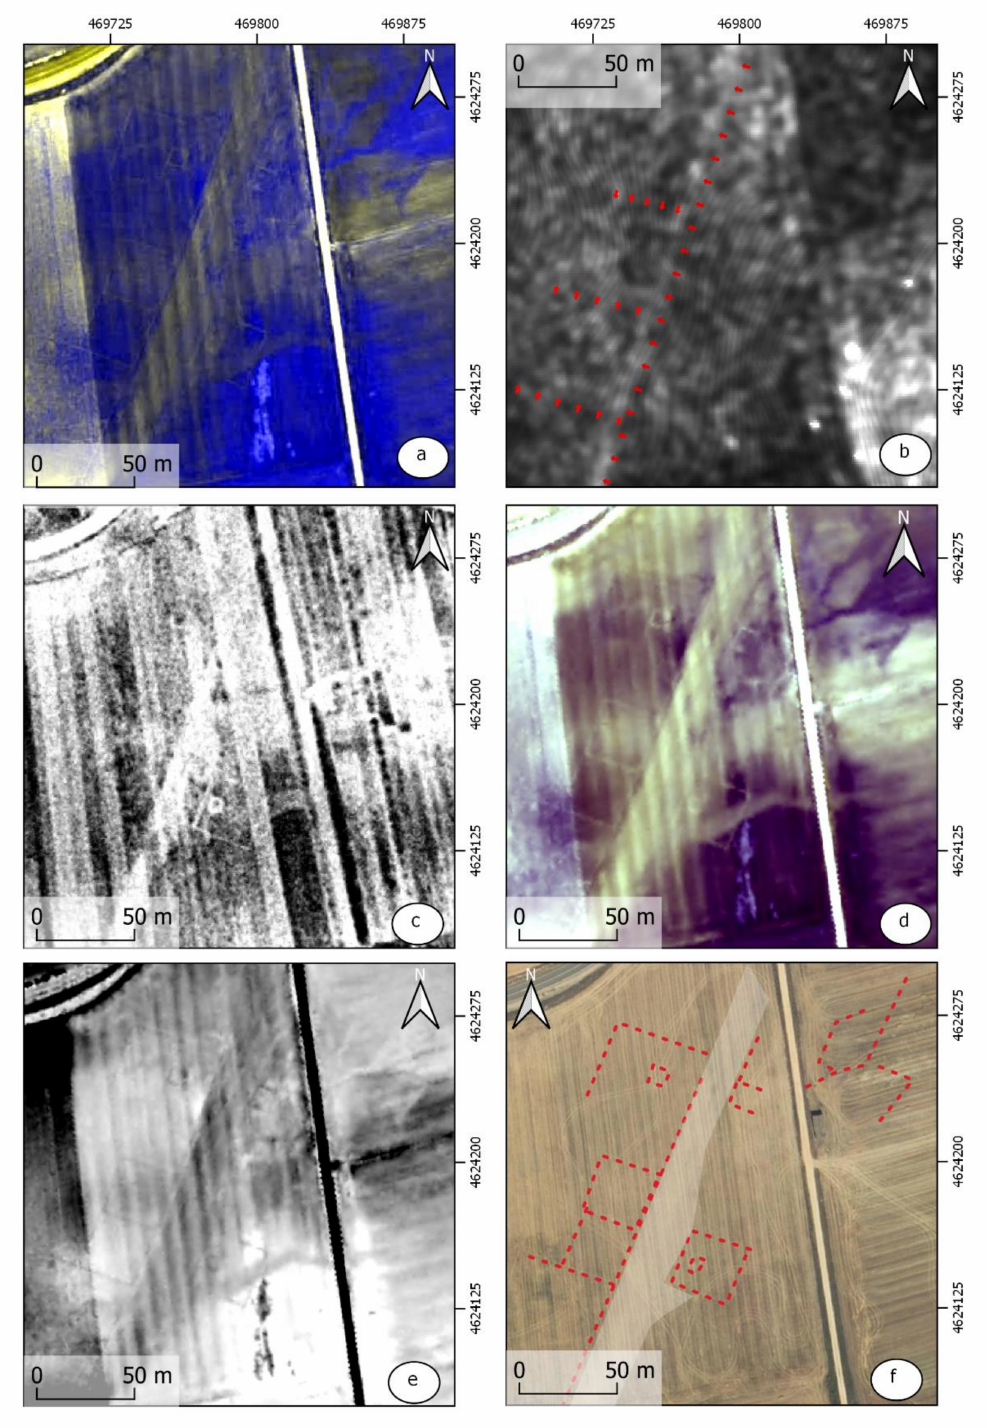
Figure 15. ( a ) PNOA 2011 50 cm (Bands B, B, IR); ( b ) PAZ 29 August; ( c ) USAF flight 1957; ( d ) LiDAR PNOA IR RG (Bands R R G); ( e ) Perpendicular Vegetation Index (Walther and Shabaani); ( f ) Google satellite